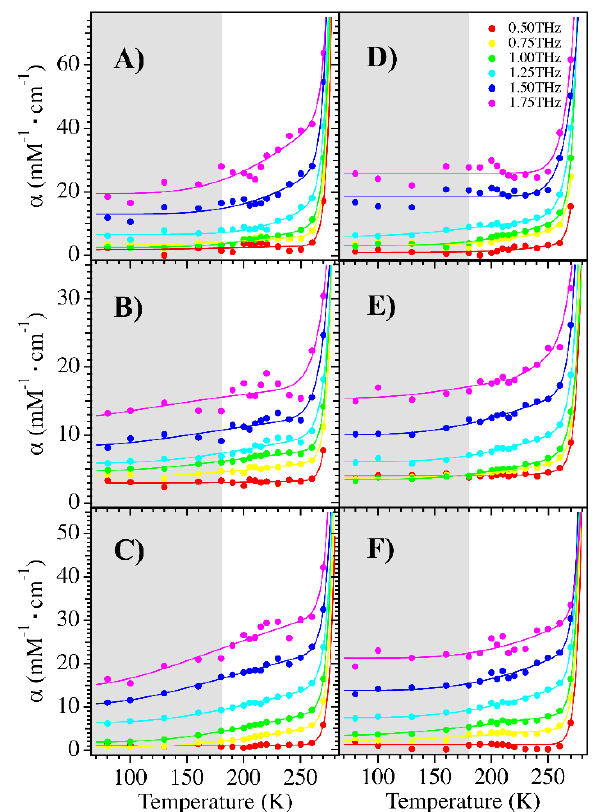
Figure 2. THz molar absorptivity for photoactive (left) and photobleached (right) RFP hydrated samples: TagRFP-T ( A , D ), mCherry ( B , E ), and mOrange2 ( C , F ), with interpolated lines as a guide for the eye, as a function of temperature at different frequencies. Note that vertical axis scale varies with different THz response: TagRFP-T 0 – 75, mCherry 0 – 35, mOrange2 0 – 55 mM − 1 cm − 1 . The low temperature region is indicated by grey shading.